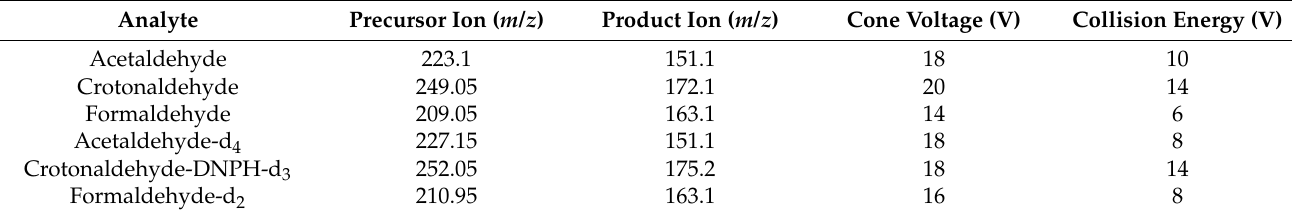
Table 2. MS/MS instrument parameters for the detection of